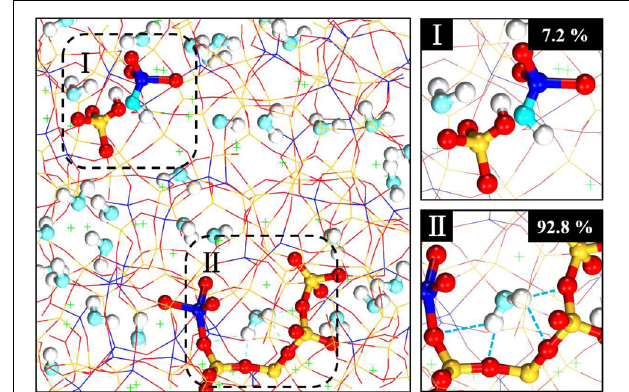
FIGURE 2 | Snapshot for the NASH gel with water penetration. The left-hand figure is the configuration of the NASH gel with a Na/Al ratio of 1. Region I and region II represent chemically dissociated water and physical adsorption water, respectively. Region I and region II are highlighted in the right-hand figures. The red ball is the BO atom in the aluminosilicate skeleton. The blue ball is the aluminum atom. The yellow ball is the silicon atom.